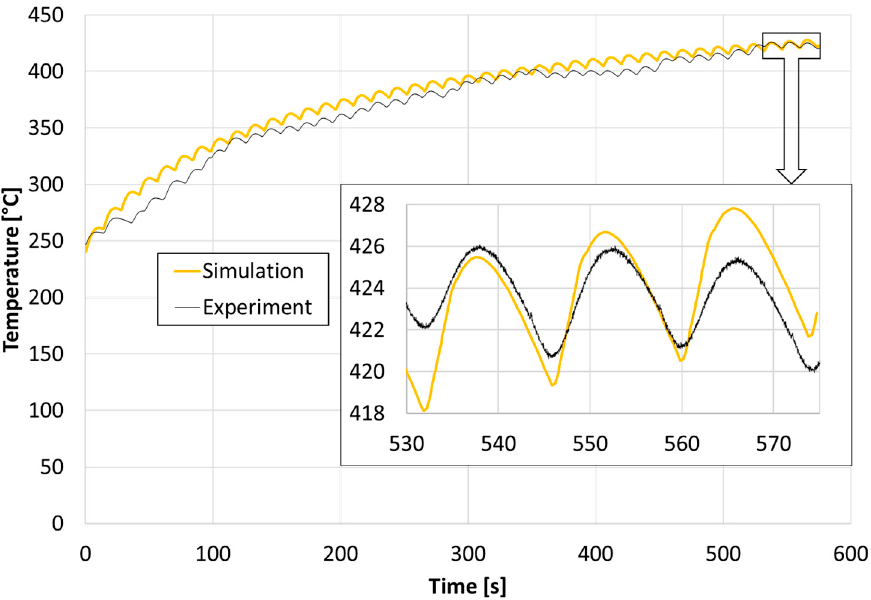
Figure 6. Comparison of temperature measured by thermocouple at a depth of 4 mm below the surface and from a sensor placed in the same place in the simulation.